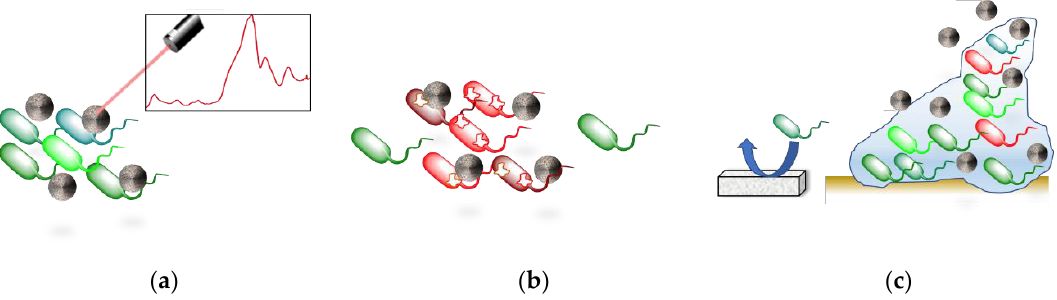
Figure 4. Summary of the silicon-based nanomaterials used for the treatment of bacterial infection depending on the stage in which they operate. ( a ) Bacteria Detection [86–89,103]. ( b ) Effect on Planktonic Bacteria [86,90–97,100,103]. ( c ) Effect on Biofilm [90,104–107].